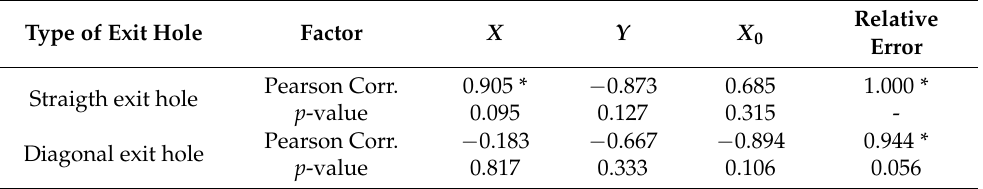
Table 4. Analysis results of correlation between tilt angle of the exit hole and coordinates of the grain collision point and the sensor indication error in simulation tests.